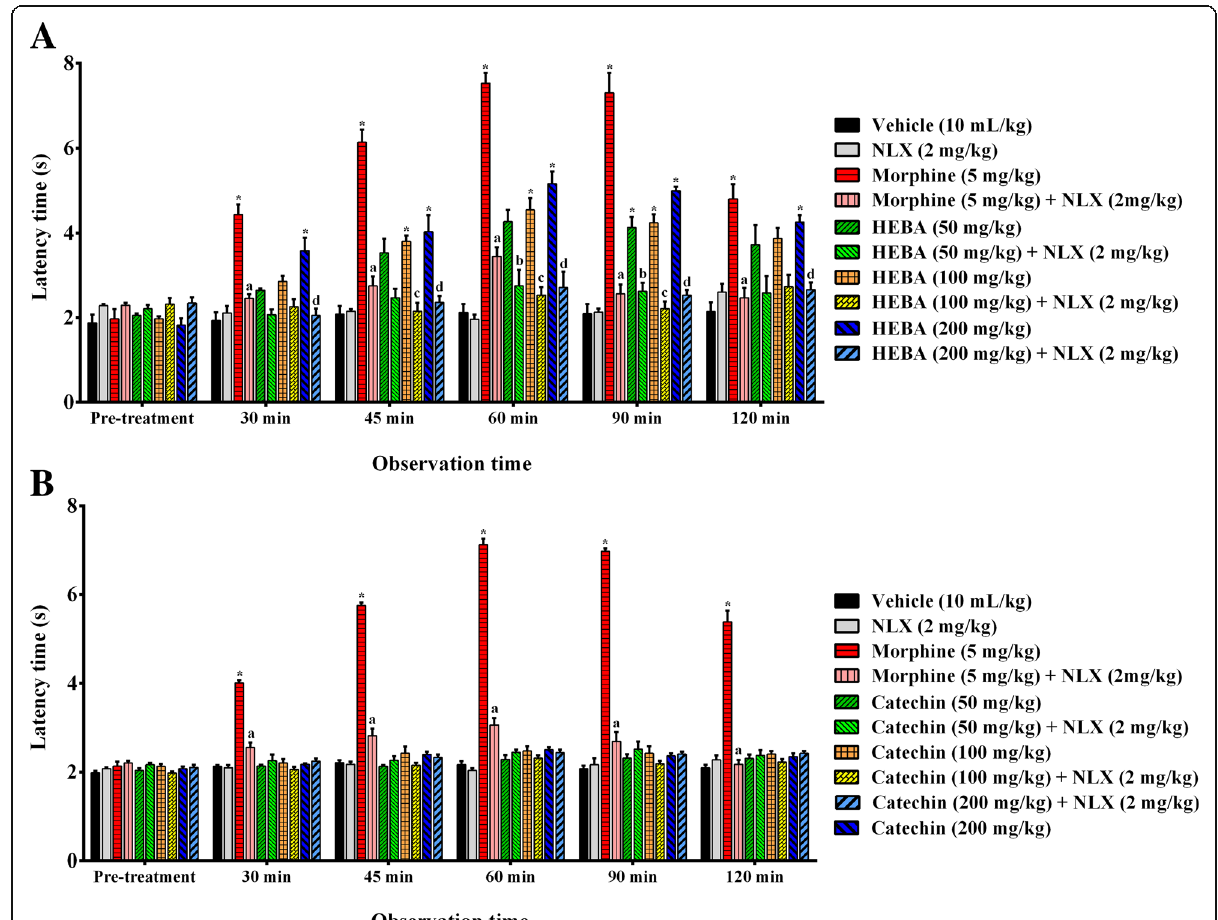
Fig. 3 Effect of morphine, HEBA, (+)-catechin and naloxone treatments on latent time in tail immersion test. Panel a shows the effect of HEBA and naloxone pre-treatment on latency. Panel b shows the effect of (+)-catechin and naloxone pre-treatment on latent time. Data are presented as mean ± SEM ( n = 5). * represents p < 0.001, compared to control group mice. a, b, c and d represent p < 0.001, compared to 50, 100 and 200 mg/Kg b.w. dose treatment group respectively. HEBA= hydro-methanolic extract of the bark of A. lacucha . NLX =